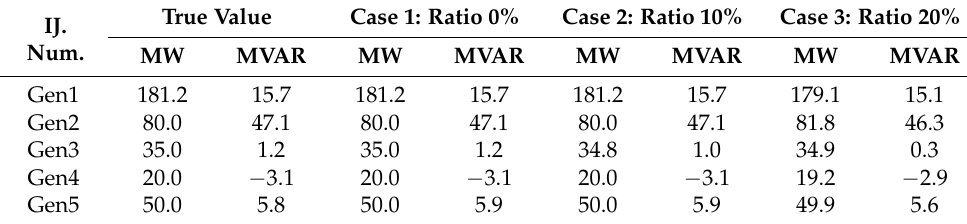
Table 6. Estimated generation for Scenario A.